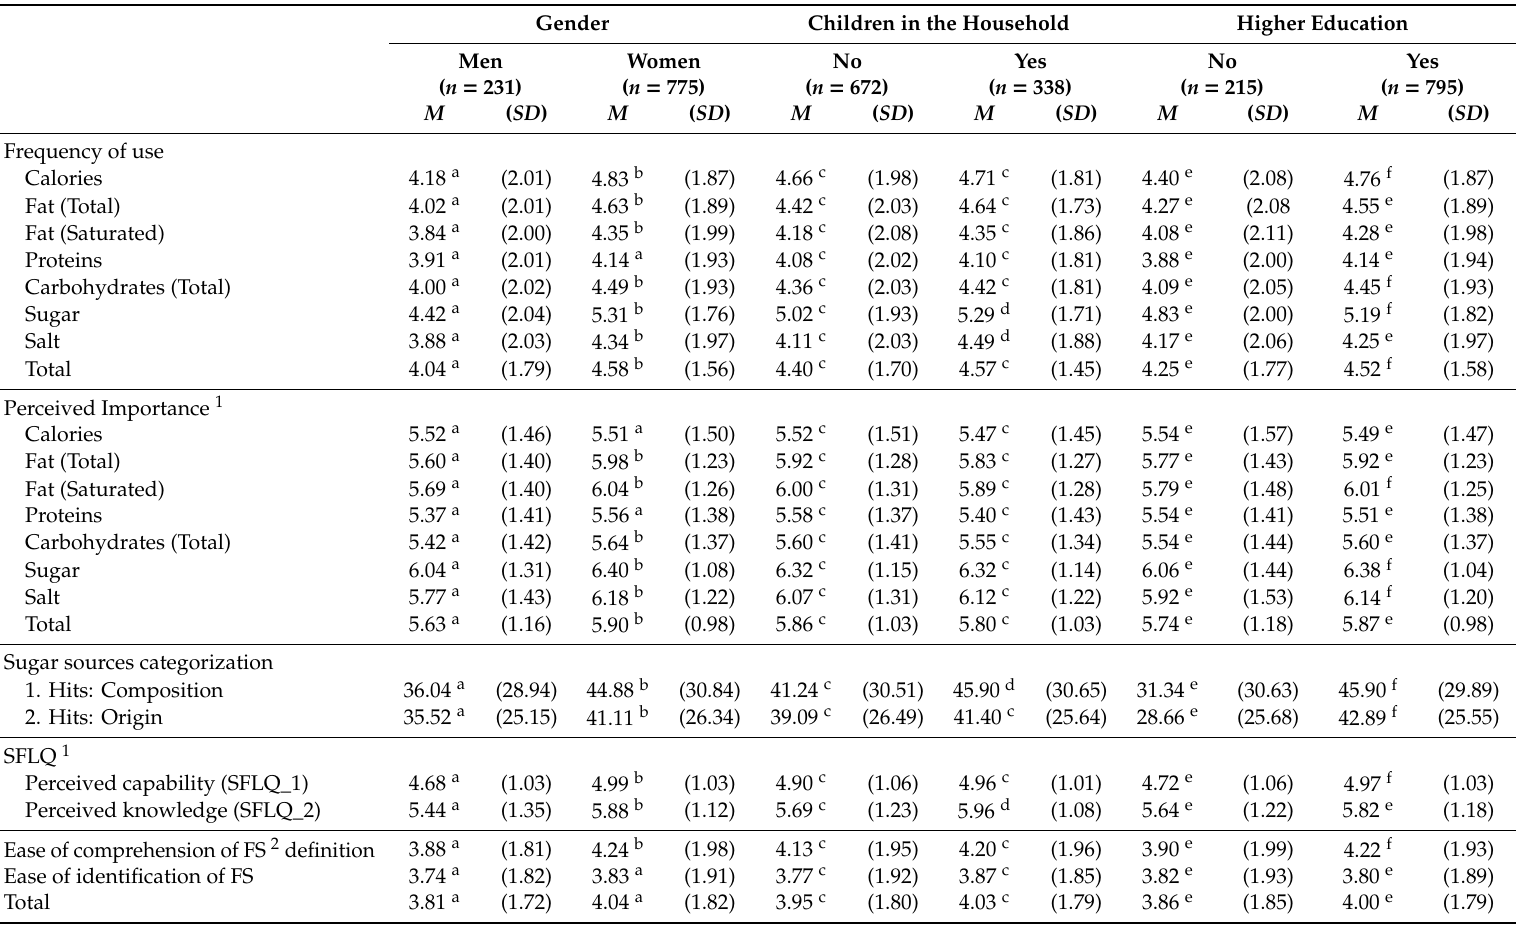
Table 1. Individual di ff erences across variables according to gender, presence of children in the household, and level of education. Gender Children in the Household Higher